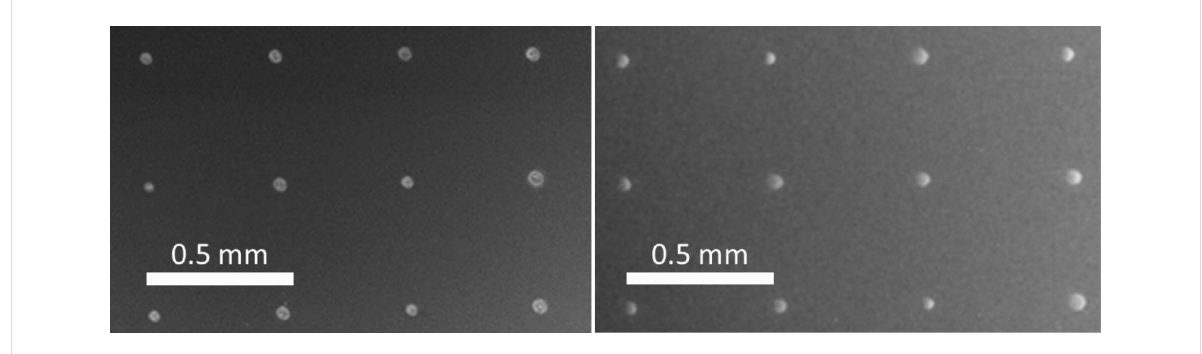
Figure 7: Optical micrographs of a laser-generated spot array on glass (left) and a corresponding array after PVD indium island growth (right).